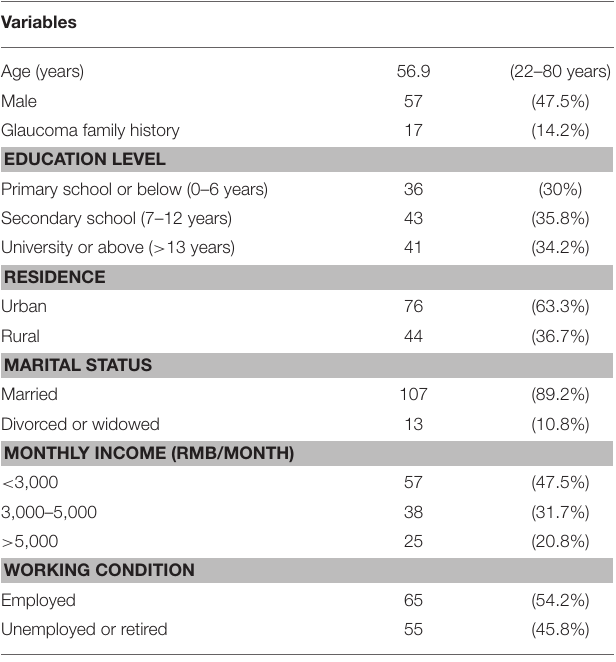
TABLE 1 | Sociodemographic characteristics of 120 patients with primary